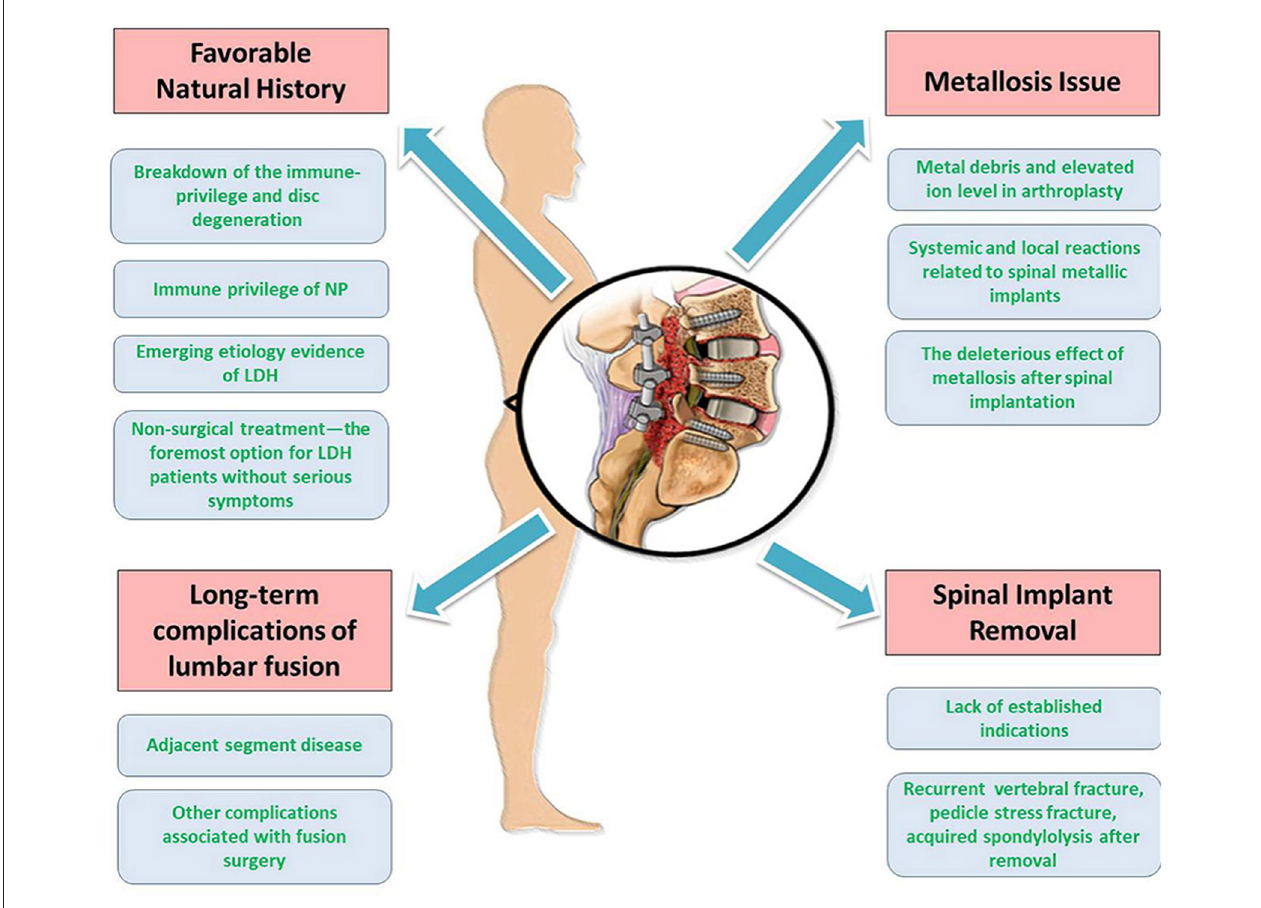
FIGURE 4 | Summarizations of the different aspects of the review. There are tetrad critical issues pertaining to surgical treatment of LDH, i.e., favorable natural history, long-term complications of lumbar fusion, metallosis issue, and spinal implant removal.